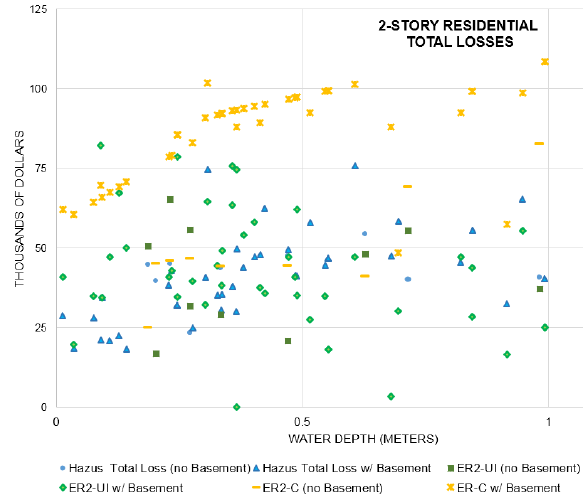
Figure 10. Total Damages versus water depth for Hazus, ER 2 using user input building value and ER 2 using computed building value, 2 Story residences, with and without basements